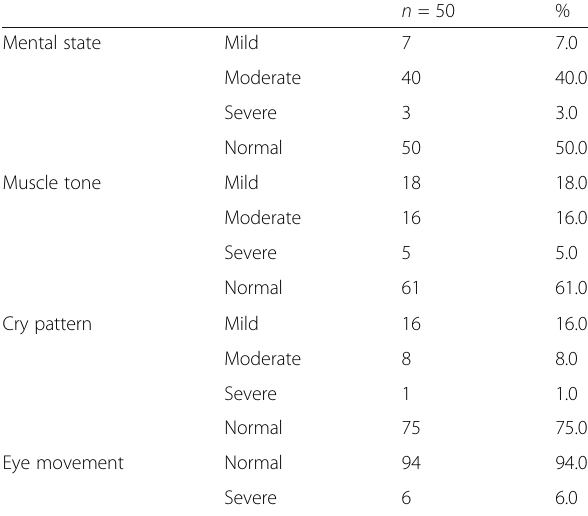
Table 5 Frequency of distribution modified BIND score (BIND- M) among the neonates in group (2)